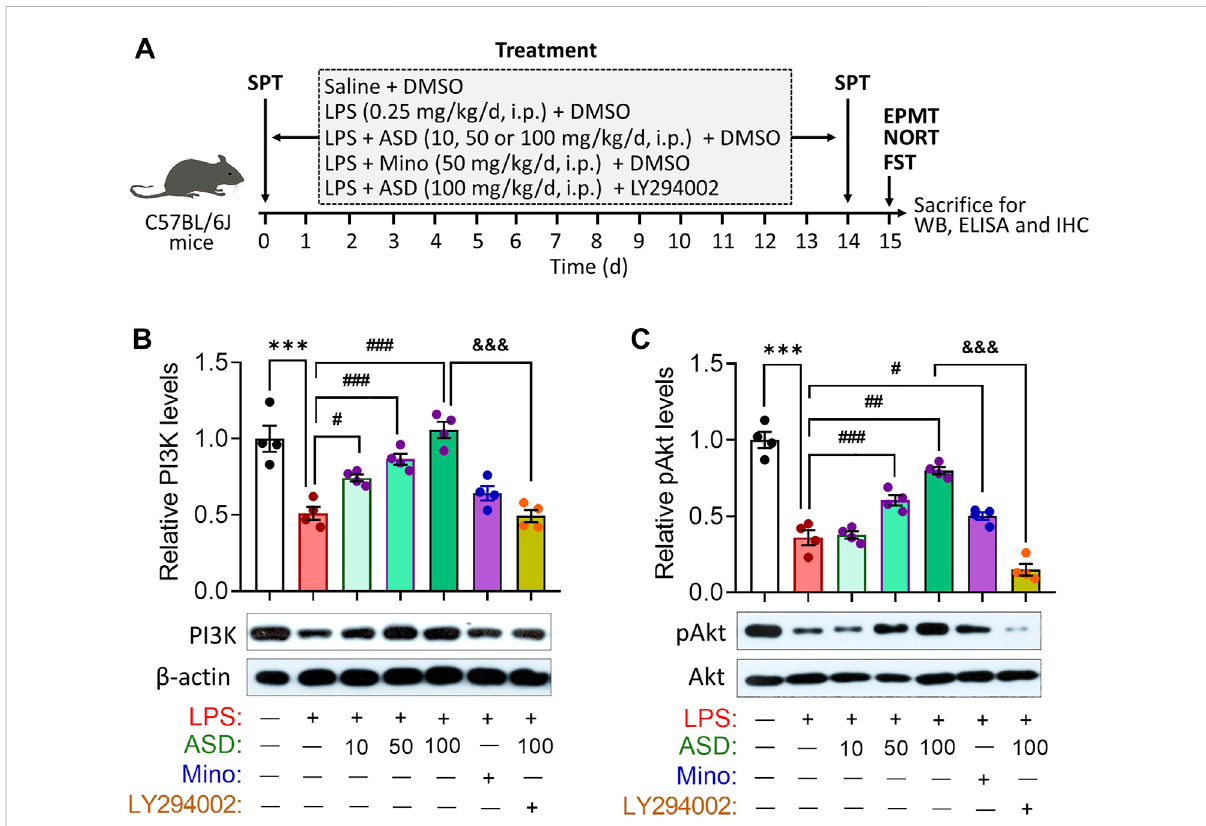
FIGURE 3 ASD activates the PI3K-Akt pathway in hippocampus of mice chronically exposed to LPS. (A) , Scheme of the experimental procedure. ASD, akebia saponin D; DMSO, dimethyl sulphoxide; ELISA, enzyme-linked immunosorbent assay; EPMT, elevated plus maze test; FST, forced swimming test; IHC, immunocytochemistry; LPS, lipopolysaccharide; Mino, minocycline; NORT, novel object recognition test; SPT, sucrose preference test; WB, western blotting. (B,C) , Western blotting shows the levels of PI3K and pAkt in the hippocampus of mice treated with saline (Ctrl) or lipopolysaccharide (LPS), then with akebia saponin D (ASD), minocycline (Mino) or PI3K-Akt inhibitor (LY294002). Levels of PI3K were normalized to those of β -actin, and levels of pAkt were normalized to those of Akt. Data are mean ± standard error of the mean (SEM) (n = 4), *** p < 0.001 vs.